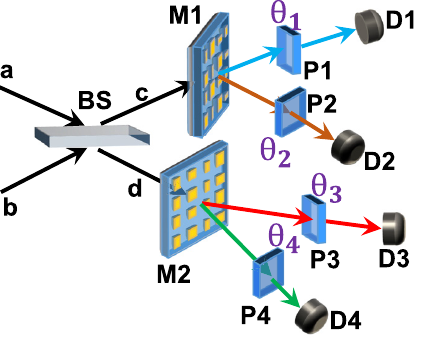
Figure 5: Sketch of metasurface-enhanced Innsbruck scheme for BSM relying on fixed metasurfaces. The entangled photon pair injects the system by the two separated paths a and b . On each path, the metasurface splits the photons into different polarization state. The polarizers P 1 and P 2 are placed before the detectors to perform the orientation dependent